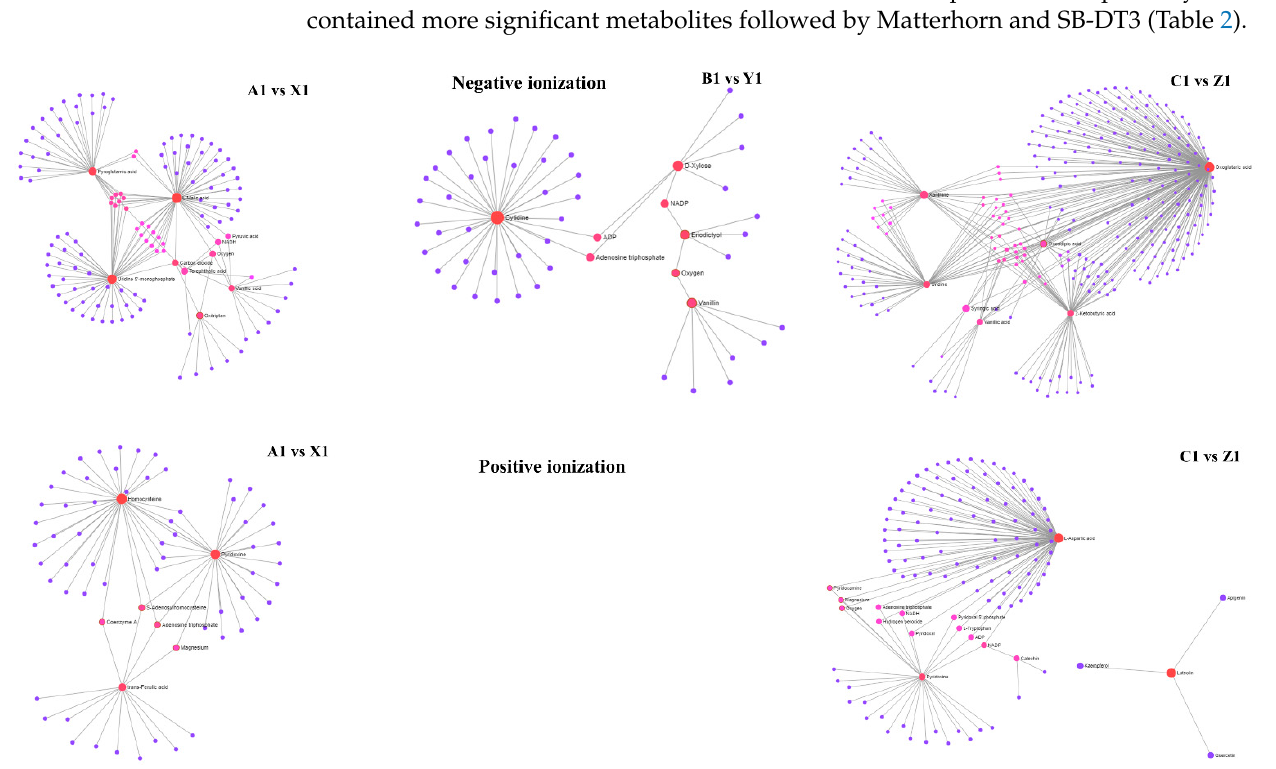
Figure 5. The metabolite–metabolite interaction network helps to highlight potential functional relationships between a wide set of annotated metabolites. Larger nodes with darker colors indicate the enriched metabolites are more important in the pathway. SB-DT2 (C1 vs. Z1) enriched with higher significant metabolites compared to other combinations.